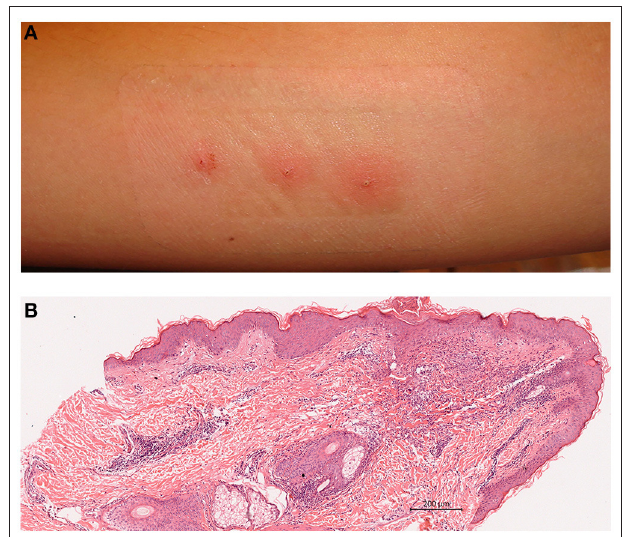
FIGURE 1 | (A) A positive pathergy reaction evaluated at 48h; pustules on erythemotous base. (B) Histopathology of positive pathergy site (haematoxylin eosin). Superficial and deep dermal perivascular inflammatory infiltrate with lymphocytes and neutrophils (Courtesy of Professor Nesimi Büyükbabani).